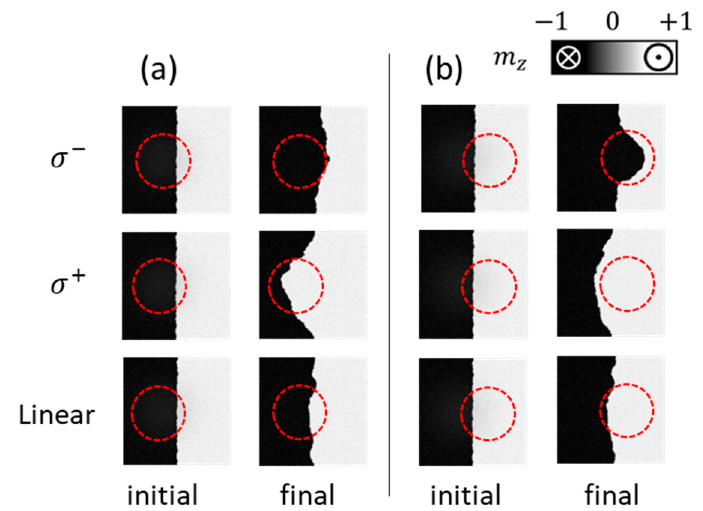
Figure 7. Initial and final snapshots of a down-up DW after 100 laser pulses of 200 ps of duration. The magneto-optical e ff ective field due to the IFE has maximum amplitude of B MO , MAX = 10 T, and its direction, either up or down, is given by the circular polarization ( σ − and σ + for top and central graphs). The fluence is F = 0.3 J/m 2 . The results for linear polarization ( B MO , MAX = 0 ) are shown in bottom graphs. The red dotted circles indicate the location of the laser beam. The in-plane size is 1.5 µ m × 1.5 µ m, and the center of laser was displaced 192 nm to the left ( a ) or to the right ( b ) of the DW.